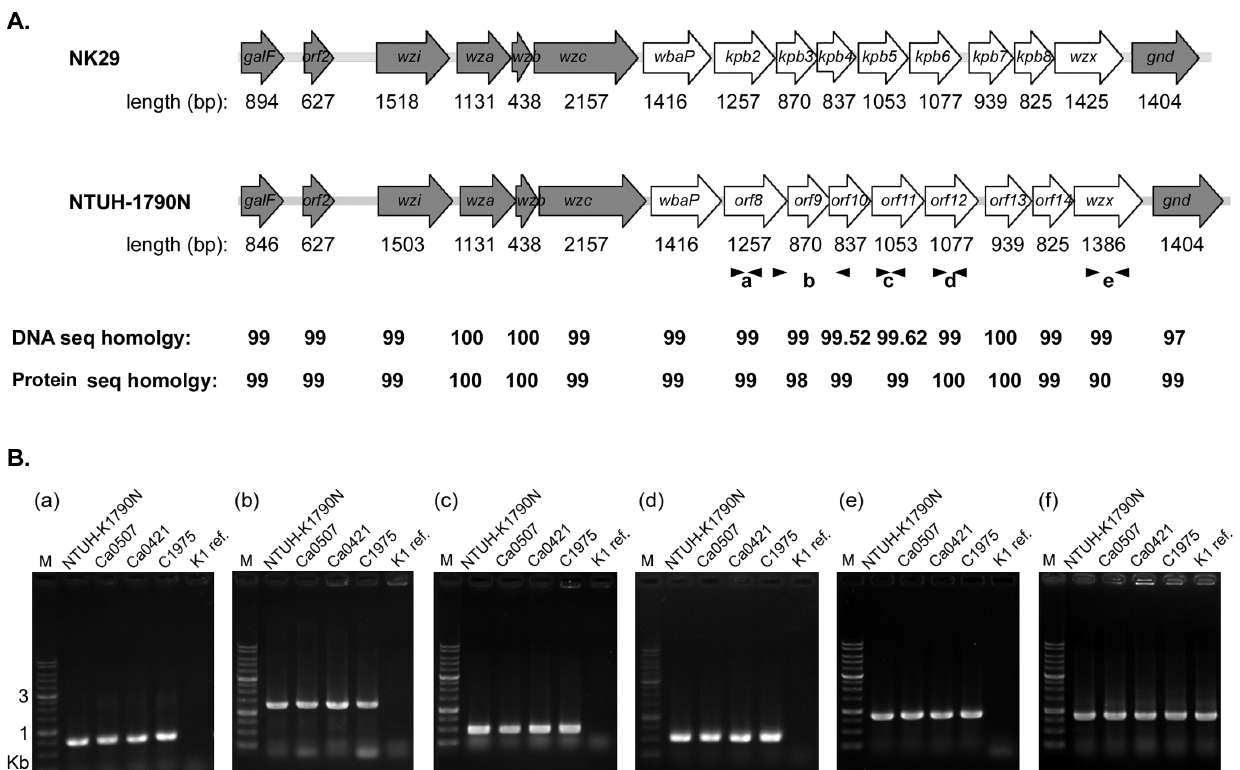
Figure 1. NTUH-K1790N cps -PCR genotyping in K.pneumoniae . ( A ) Comparison of the capsular polysaccharide synthesis ( cps ) regions of NK29 (Shu et al ., 2009) and NTUH-K1790N strains. ORFs are shown by arrows, with the length as indicated below. Gray arrows show the conserved ORFs, and white arrows show the variable ORFs in different serotypes. The homology score between NK29 and NTUH-K1790N is compared using the sequence alignment program ClustalW2 (http://www.ebi.ac.uk/Tools/msa/clustalw2/). Black arrowheads refer to 5 pairs of PCR primers (a-e) used for cps genotyping. ( B ) cps -PCR genotyping of K. pneumoniae strains using primers as indicated: a . KN2-orf8-F and KN2-orf8-R; b . KN2-orf8-F2 and KN2- orf10-R; c . KN2-orf11-F and KN2-orf11-R; d . KN2-orf12-F and KN2-orf12-R; e . KN2-wzx-F and KN2-wzx-R; f . 23S rRNA as control for K. pneumoniae . K1 ref. presents the reference strain for the K1 serotype.G.